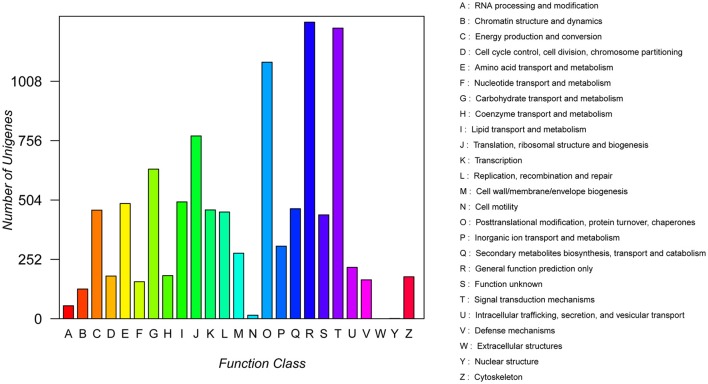
Clusters of Orthologous Groups (COG) functional classification of assembled unigenes. All 10,127 unigenes were aligned to 25 COG groups. The letters on the x-axis indicate the COG categories as listed on the right of the histogram, and the y-axis indicates the number of unigenes.